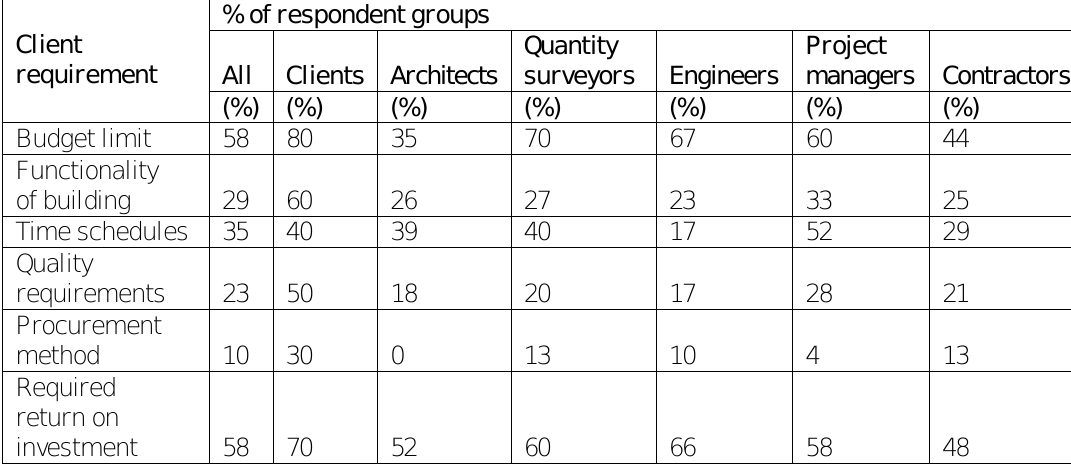
Table 5: Perceived extent to which clients always know their requirements at the outset of the project